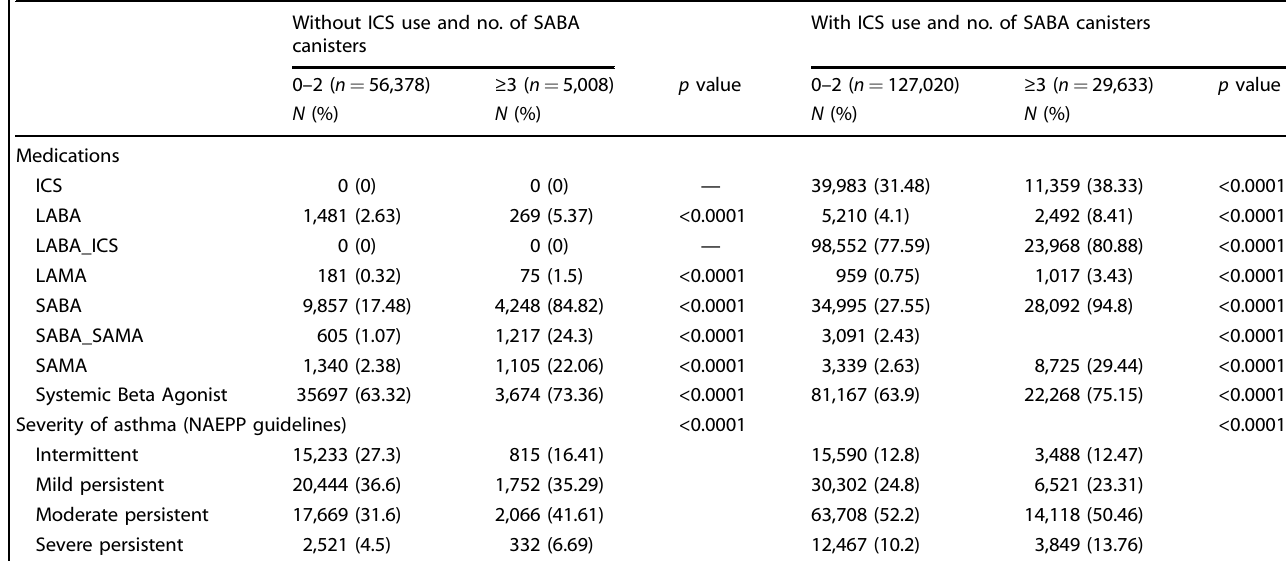
With ICS use and no. of SABA